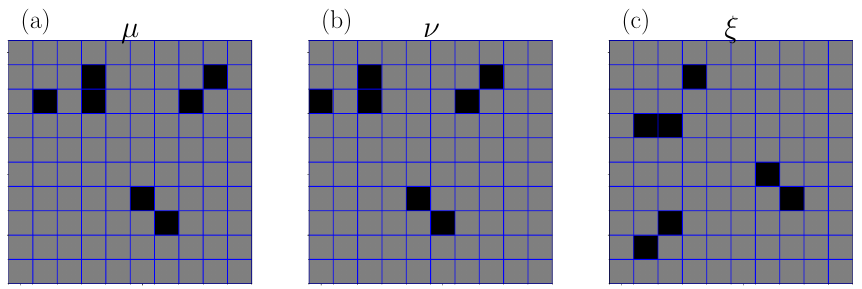
Figure 1. µ , ν and ξ are three examples of density of attractors. The black boxes have a measure of 1 and the grey a measure of 0. ν is a shift of µ , but ξ is very different of µ and ν . Finally, ν (resp. ξ ) have no common (resp. one common) point with µ . The Euclidean distance between µ and ν (resp. ξ ) is equal at 3 . 74 (resp. 3 . 46), whereas the Wasserstein distance is equal to 1 between µ and ν , and 3 . 27 between µ and ξ .